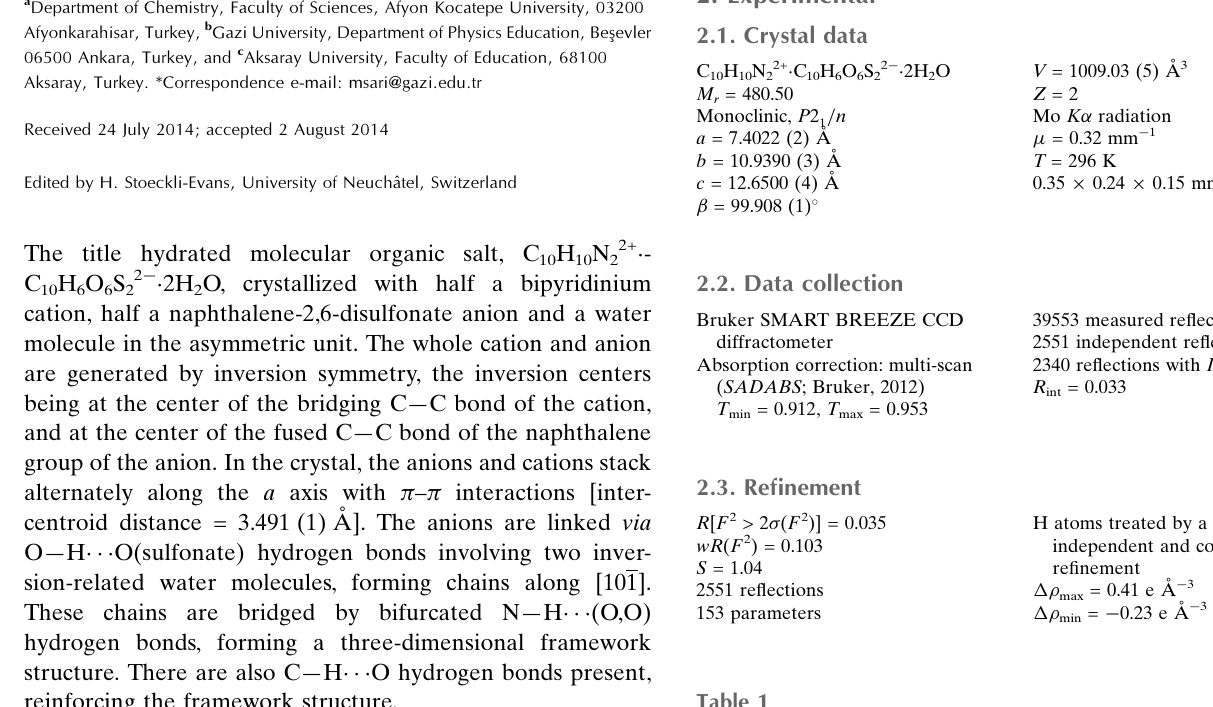
Hydrogen-bond geometry (A˚ , (cid:4)